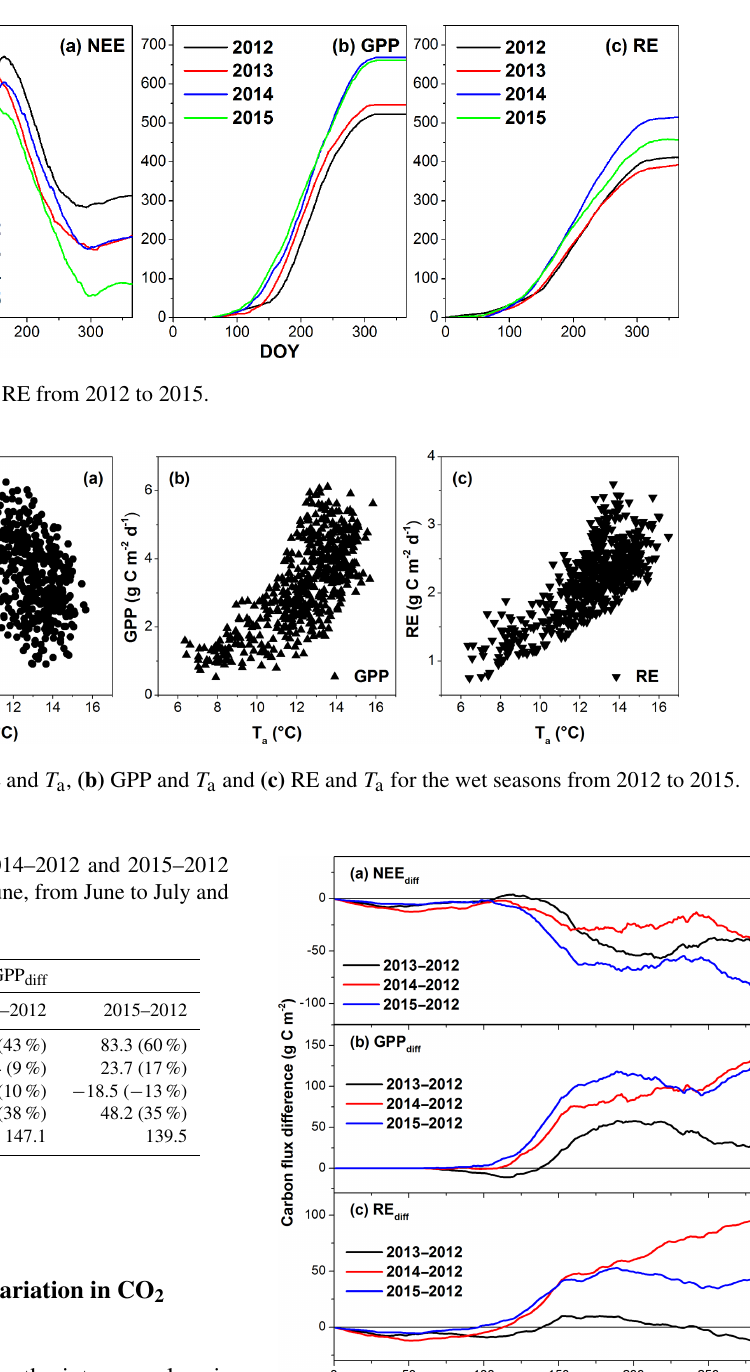
Figure 7. Seasonal variations in the differences of (a) NEE, (b) GPP and (c) RE from 2013 to 2012, from 2014 to 2012 and from 2015 to